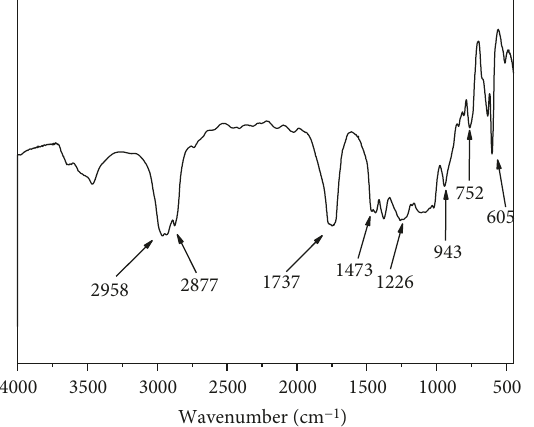
Figure 1: FTIR spectrum of L9.